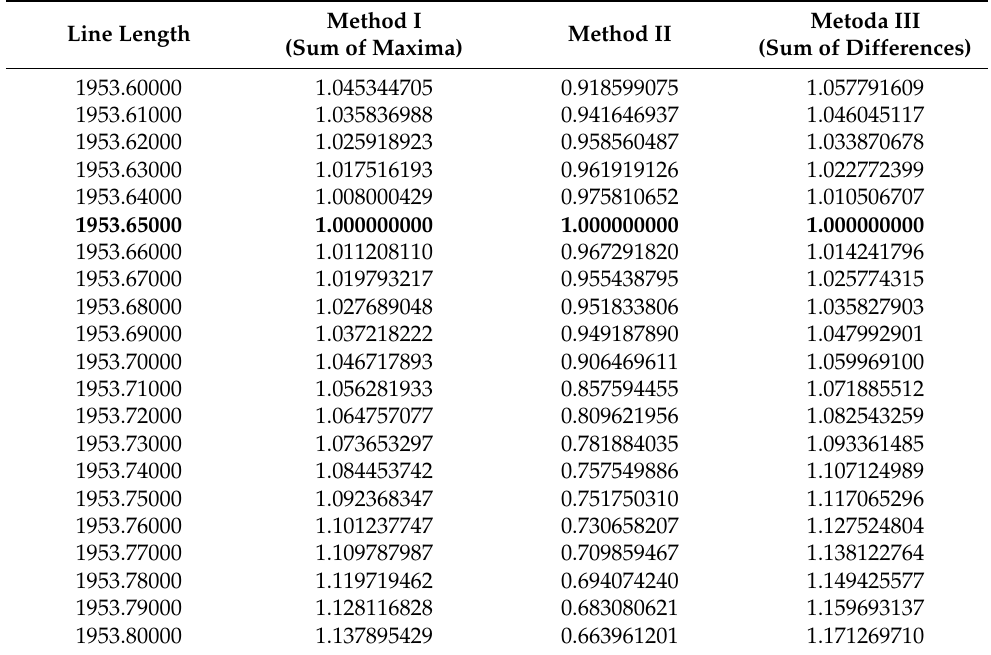
Table 5. Image line length estimation results for the accuracy ∆ = 0.01.